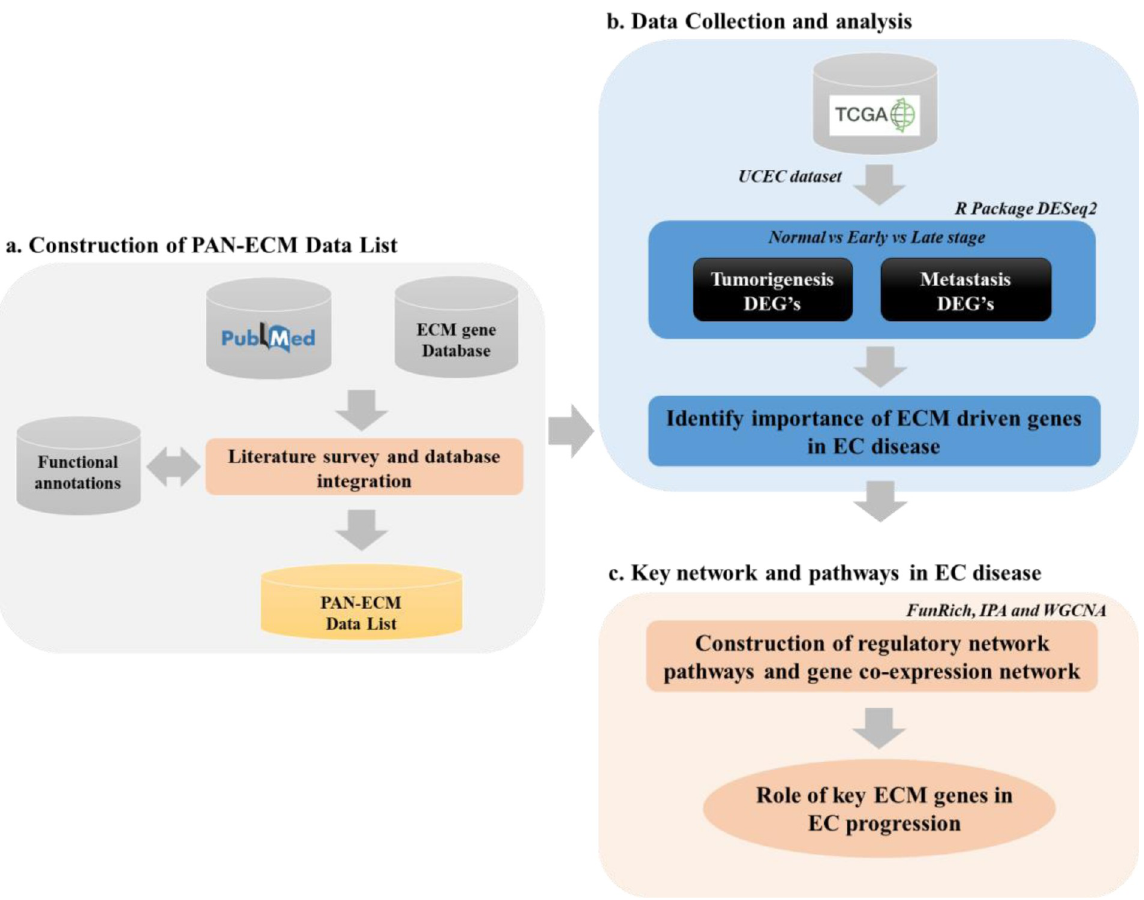
Fig 2. An overview and flowchart of the study. This study includes three main parts, (a) construction of the PAN-ECM Data List, (b) Identification of the ECMs, ECM-associateds molecules, the involved signaling pathways participating in EC development, and (c) Networking analyses for verification of the key ECM genes involved in EC